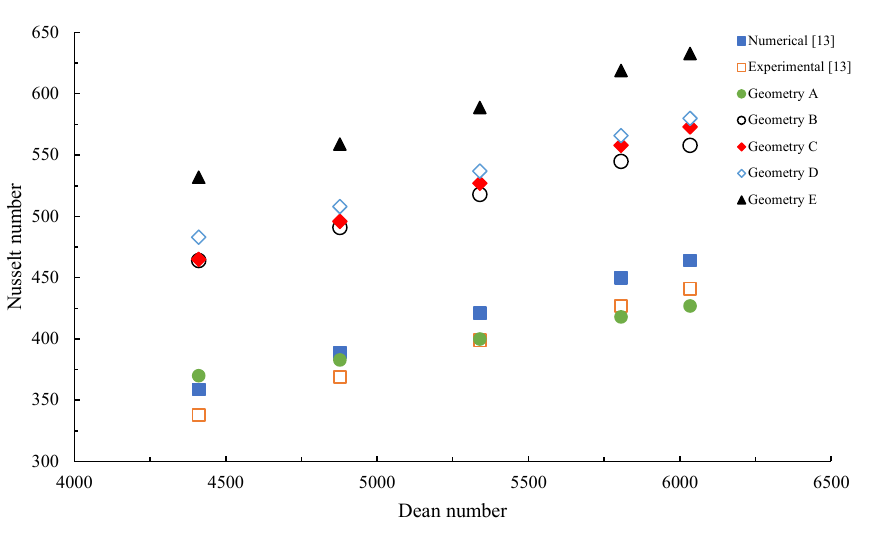
Figure 5. Nusselt number vs. Dean number for outer